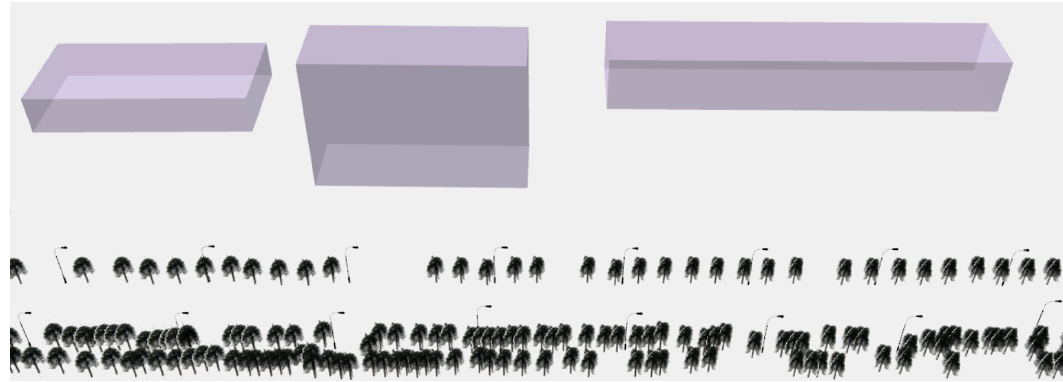
Figure 14. Part of the reference data.